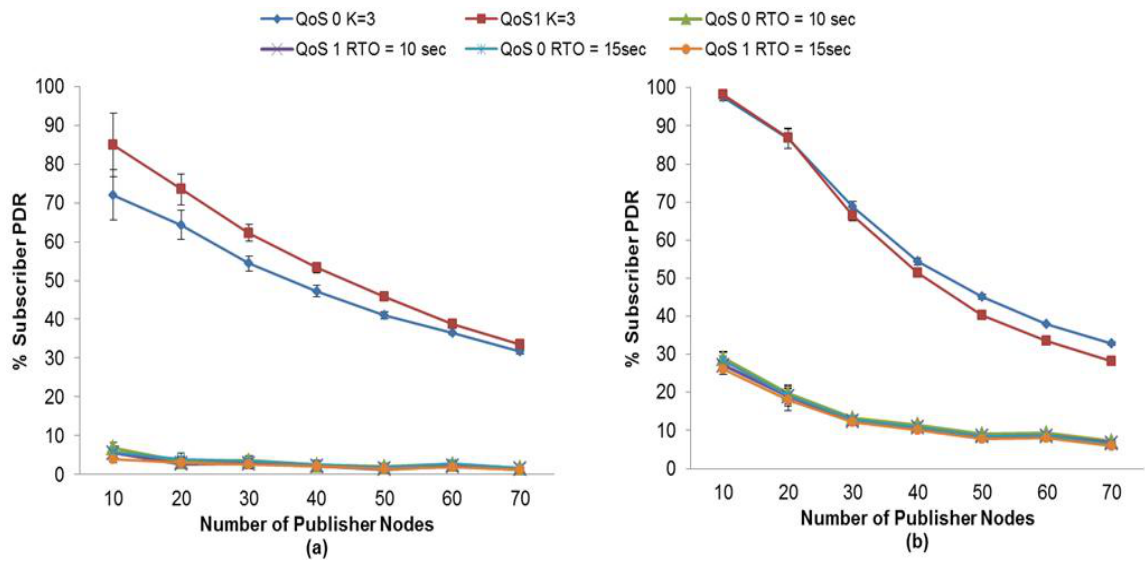
Figure 17. PDR comparisons between the RTO method of MQTT-S calculation and our proposal without ( a ) and with ( b ) MAC Acknowledgements.